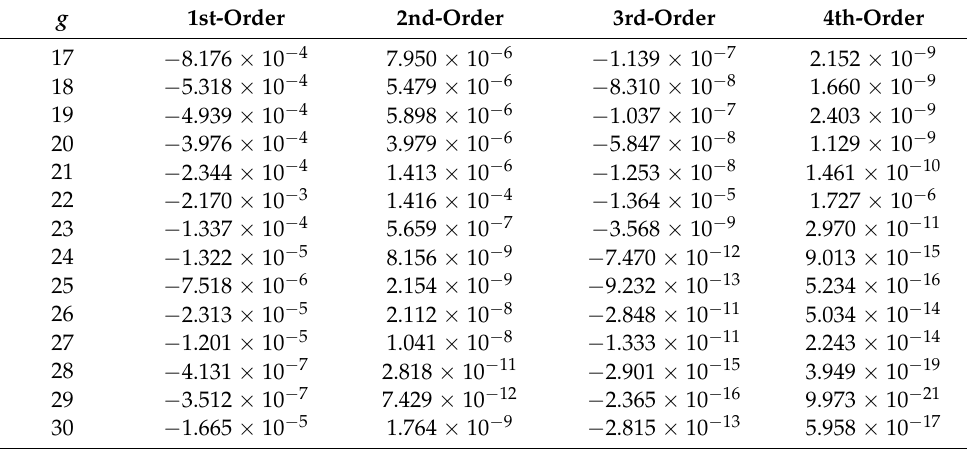
Comparison of the 1st-order through 4th-order unmixed relative